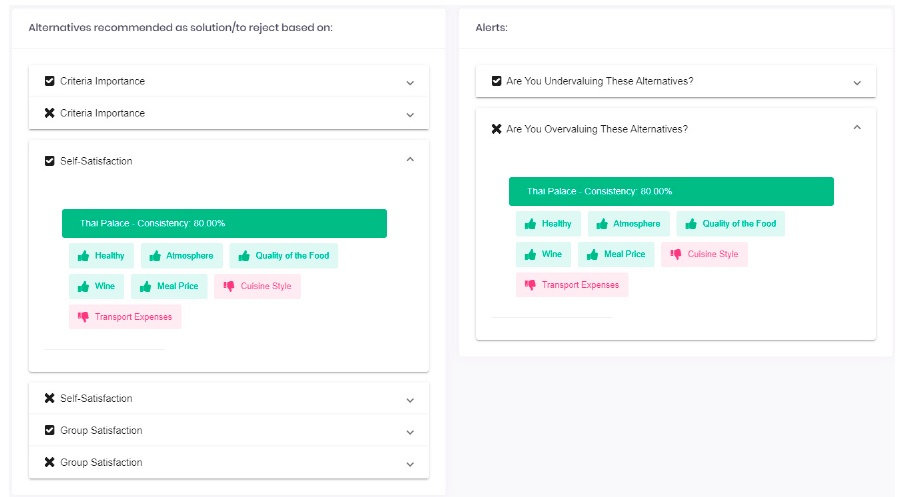
Figure 7. Elements of the “Personal Information” screen.